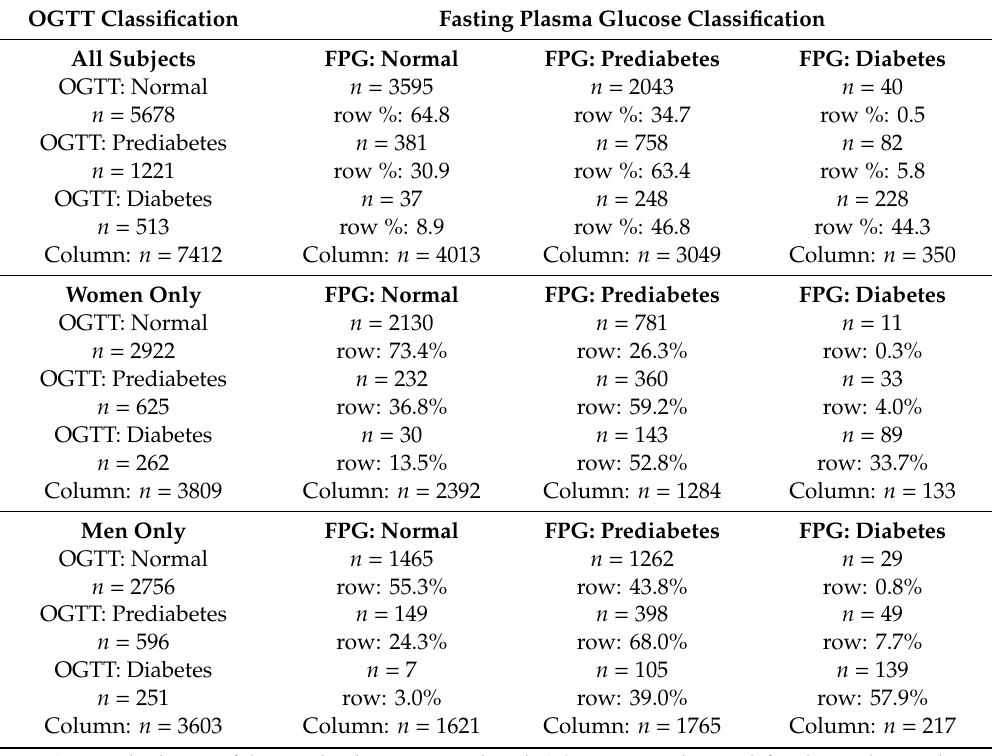
Table 4. Agreement between diabetes classifications for the OGTT and the fasting plasma glucose (FPG) test in U.S. women and men analyzed separately and combined, 2009–2016. OGTT